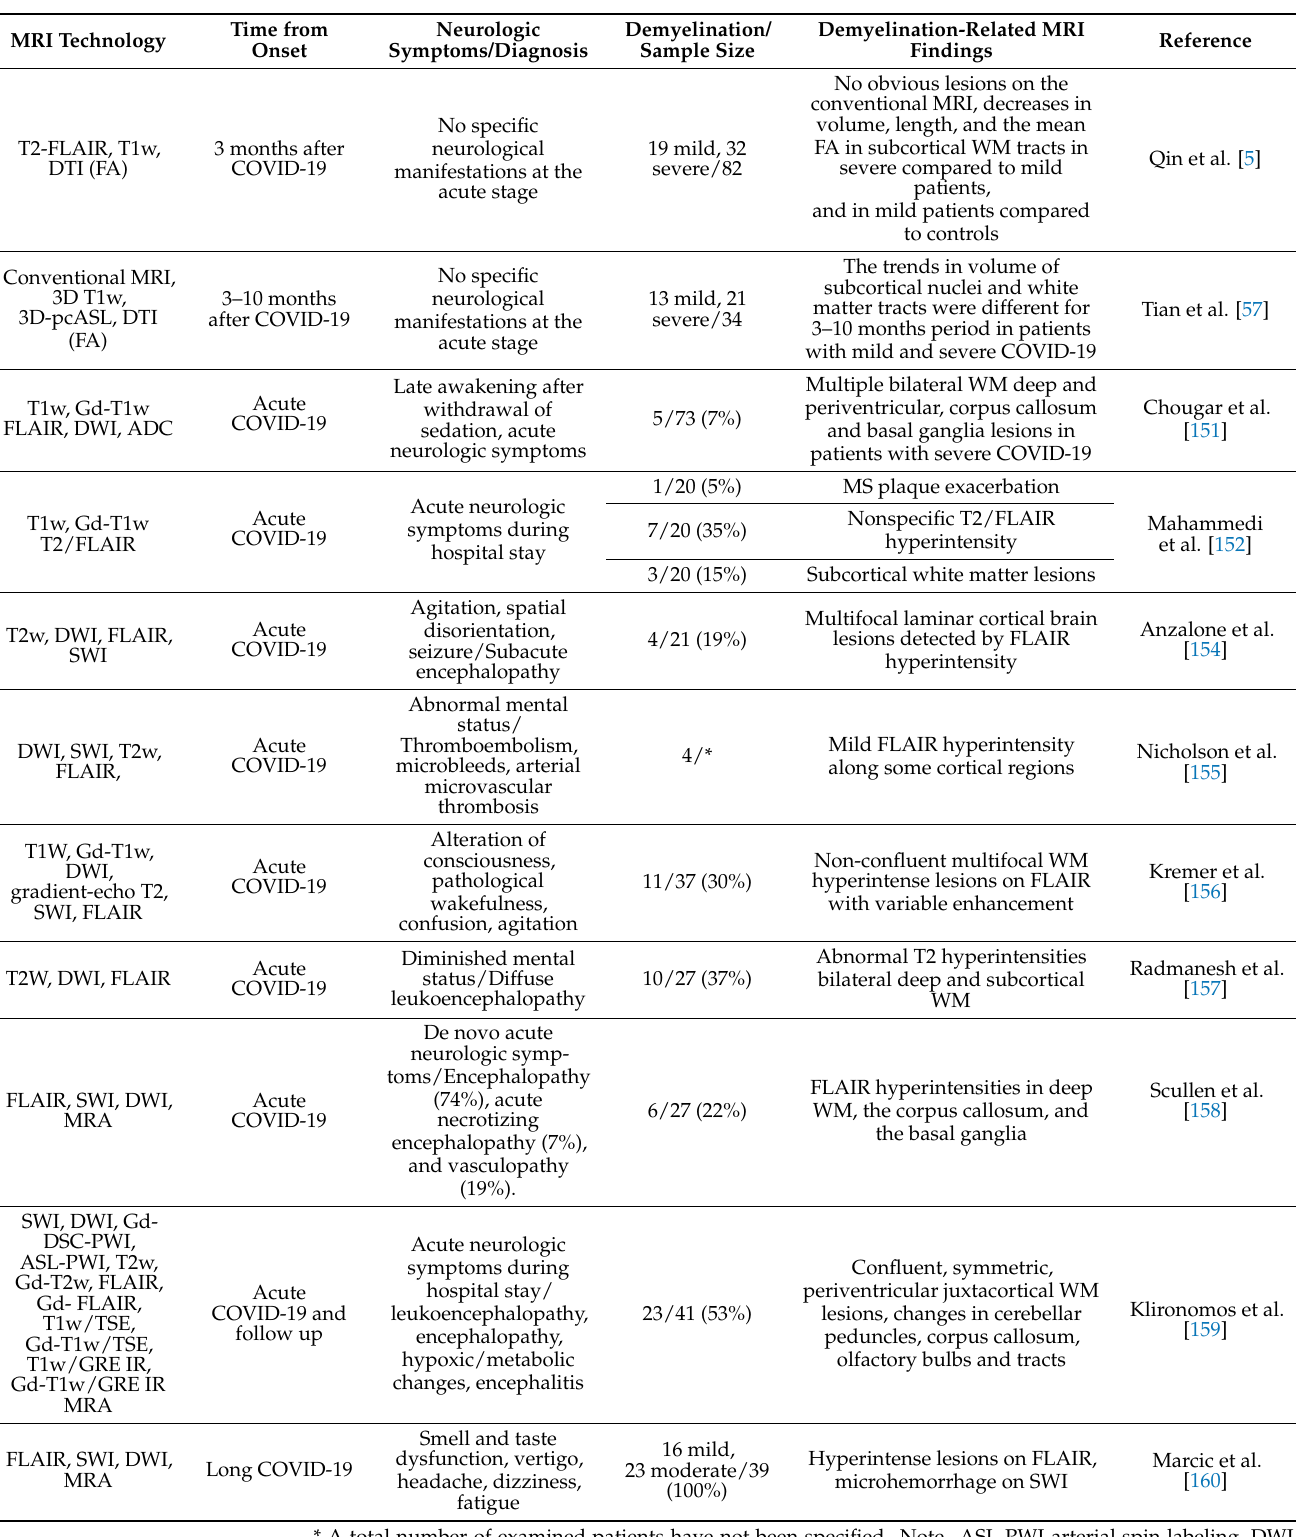
Table 2. Demyelination-related MRI findings in COVID and post-COVID